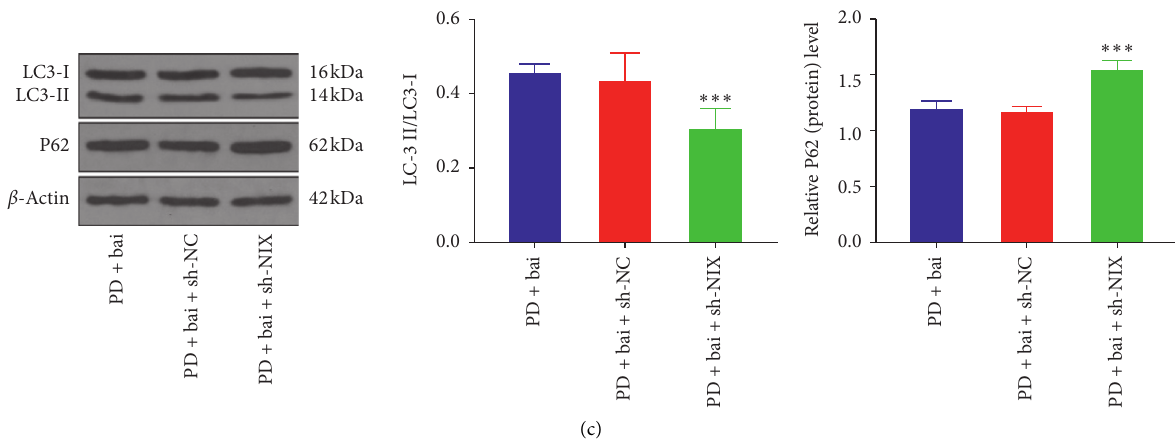
Figure 5: Downregulation of NIX reversed baicalein induced mitochondrial autophagy. The effect of NIX on baicalein induced mito- chondrial autophagy was observed through inhibiting the expression of NIX in PD rats by sh-NIX. (a) The expression of NIX was detected by RT-qPCR. (b) Mitochondrial membrane potential was detected by JC-1 fluorescence staining. (c) The expressions of LC3 and P62 were detected by WB. N � 6. The data in the figure are all measurement data and the data are expressed as mean ± standard deviation; one-way ANOVA was used for variance analysis; Tukey’s multiple comparisons test was used for post hoc test. ∗∗∗ P < 0 . 001.